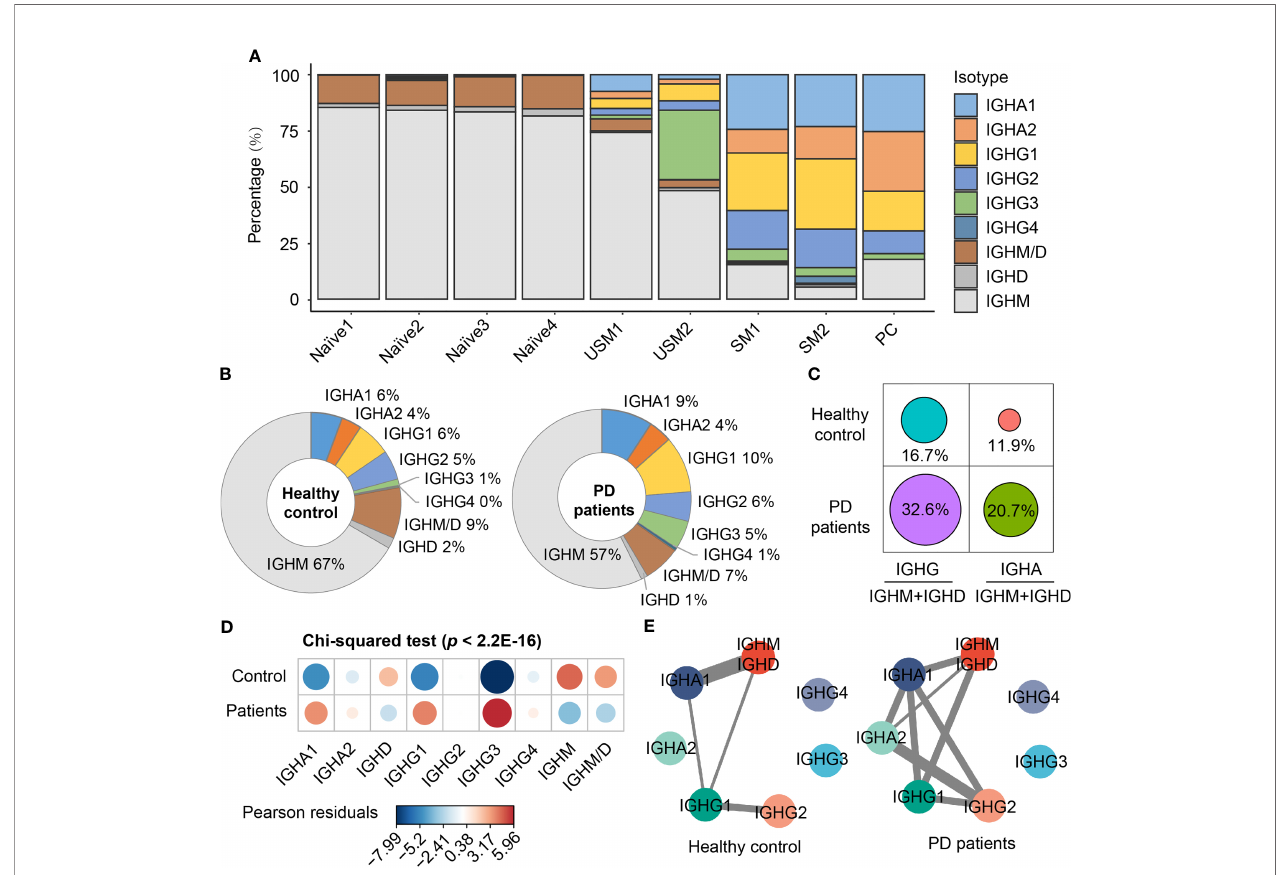
FIGURE 2 | Immunoglobulin isotypes and class-switching events of BCRs in PD patients and healthy controls. (A) Immunoglobulin isotype distribution in each B cell subsets. (B) Pie chart shows the percentage composition of Ig isotypes in PD patients and healthy controls. (C) The ratio of IgG to IgM/D and IgA to IgM/D between PD patients and healthy controls. (D) Bubble chart shows the Pearson ’ s residuals of sample groups from Ig isotypes. Red circles indicate an over-representation, and blue circles indicate an under-representation. (E) Class-switching events in PD patients and healthy controls. The thickness of the line indicates the number of sharing clonotypes between two Ig